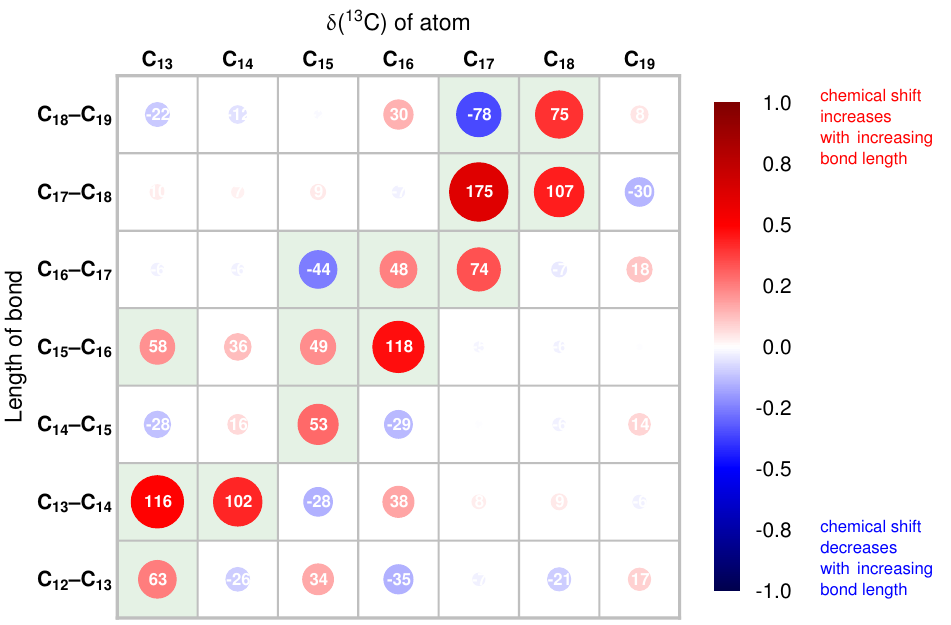
Figure 3. Correlation matrix showcasing the geometric sensitivity of 13 C chemical shifts towards changes in selected C-C bond lengths in rings C and D of PCB in AnPixJg2 and Cph1 ∆ 2 (P r state). Colour and size of the circles correspond to the Pearson correlation coefficient (see colour bar on the right), whereas white numbers denote the slope of linear regression (in ppm Å -1 ). Mint cells are significant at p < 0.0001; n = 405